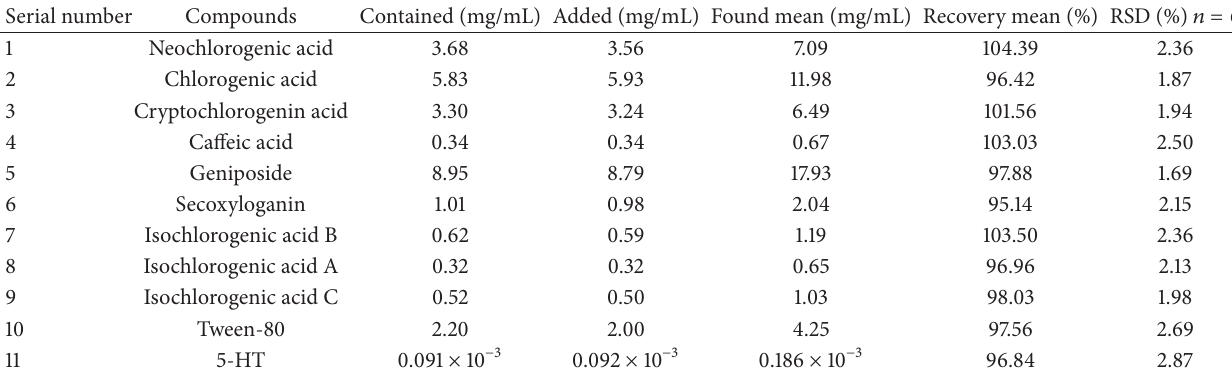
Table 4: Recovery of the compounds in Reduning injection.